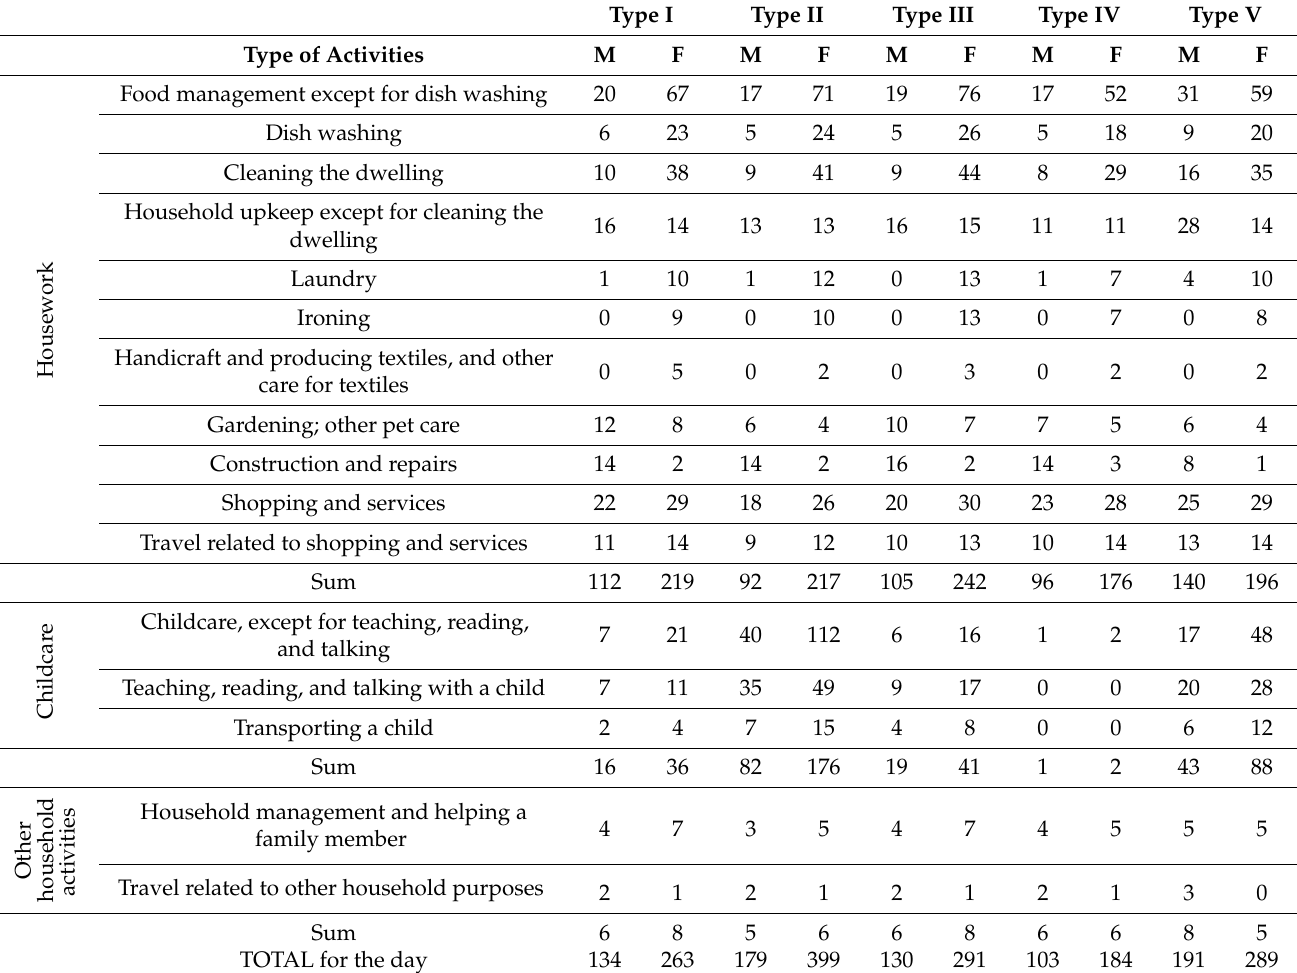
Table 1. Average time spent performing activities (minutes) in particular types of